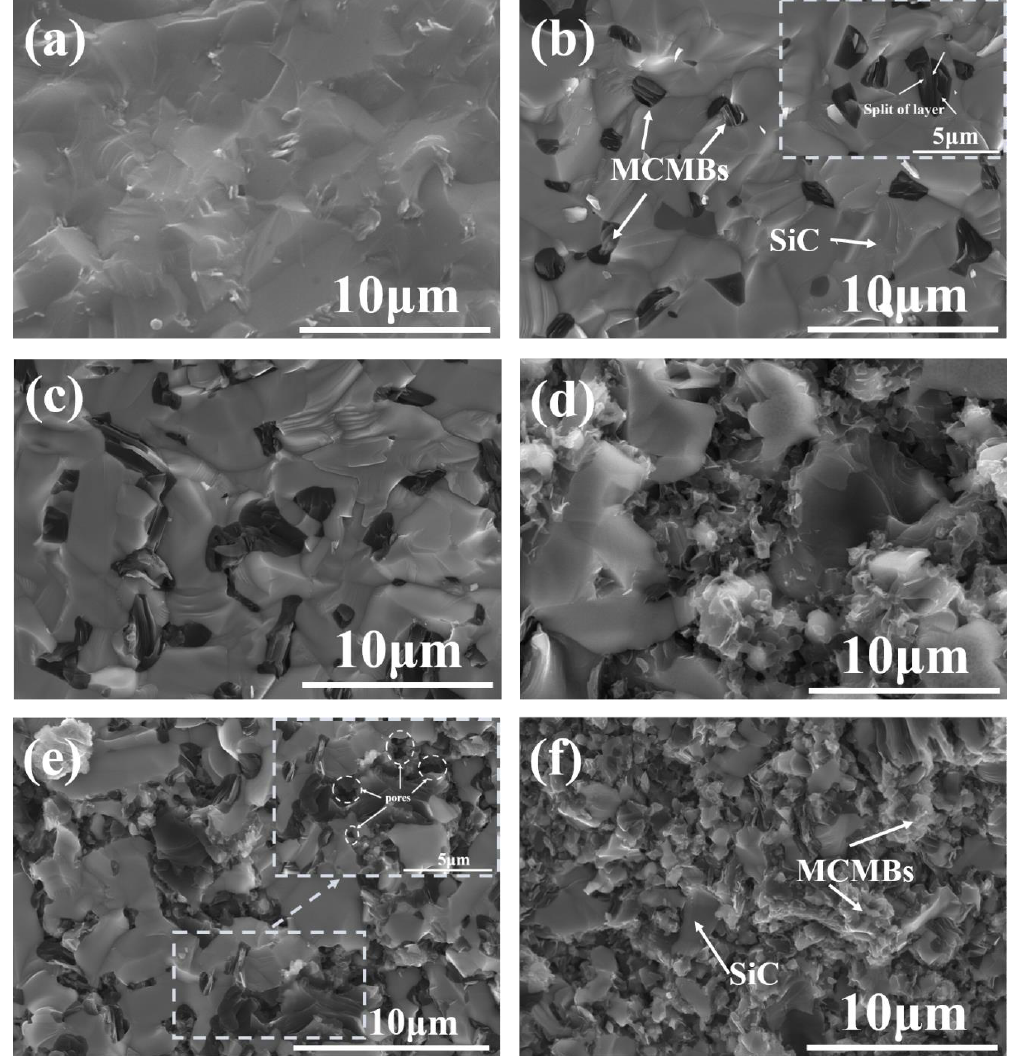
Figure 2. Microstructure (fracture surfaces) evolution of MCMB–SiC composites as MCMB content increases from 0 (M-0) to 30 wt % (M-30): ( a ) M-0; ( b ) M-5; ( c ) M-10; ( d ) M-15; ( e ) M-20; ( f )